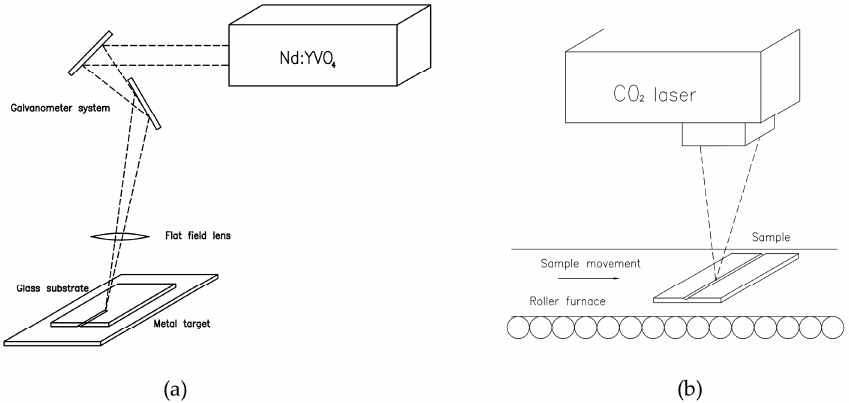
Figure 1. Experimental setups employed for the fabrication of the channel over soda-lime glass. Schemes of ( a ) the fabrication of the channel; and ( b ) the subsequent thermal treatment to reduce the roughness of the structure.